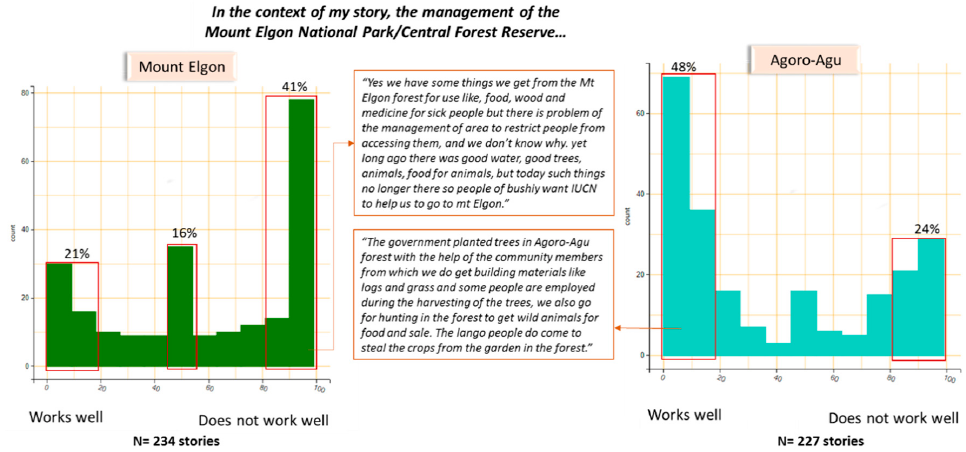
Figure 6. People’s perceptions about the way the protected area is managed.